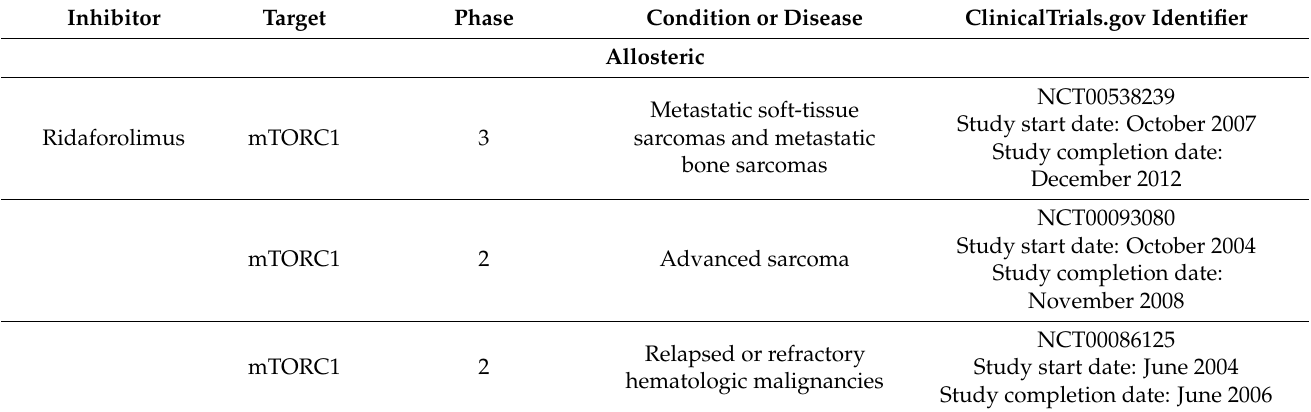
Table 8. Other mTOR inhibitors in Phase 2/3 clinical trials 1